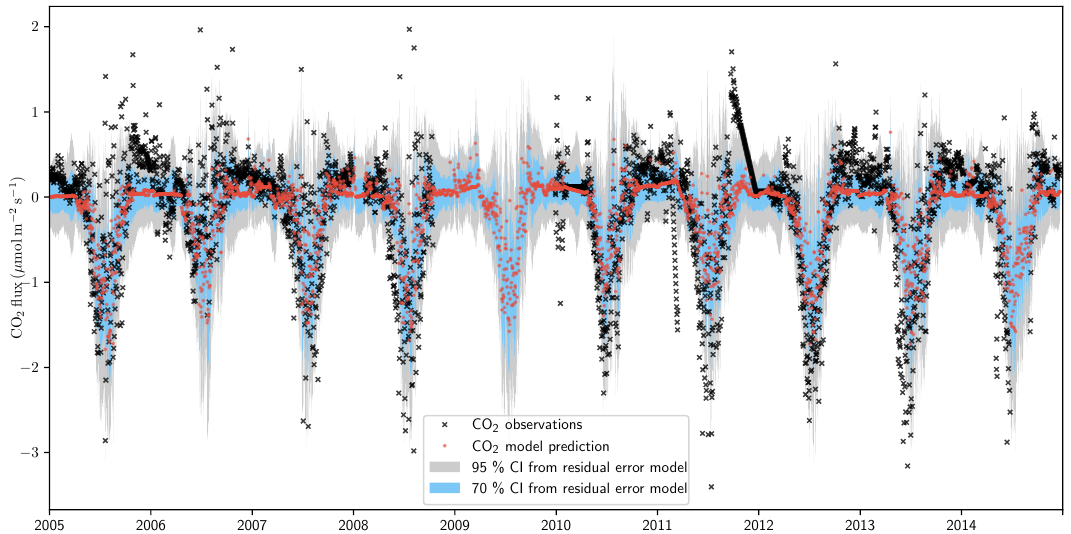
Figure 10. Output CO 2 flux (red dots) with parameters from the posterior mean. Carbon dioxide observations (black crosses) and model- predicted fluxes with confidence intervals from the ARMA(2,1) modeling of a set of 1000 residual time series are also shown. As with methane, most of the observations are inside the confidence intervals. The parameter variations in the posterior probability distribution are not reflected in these confidence